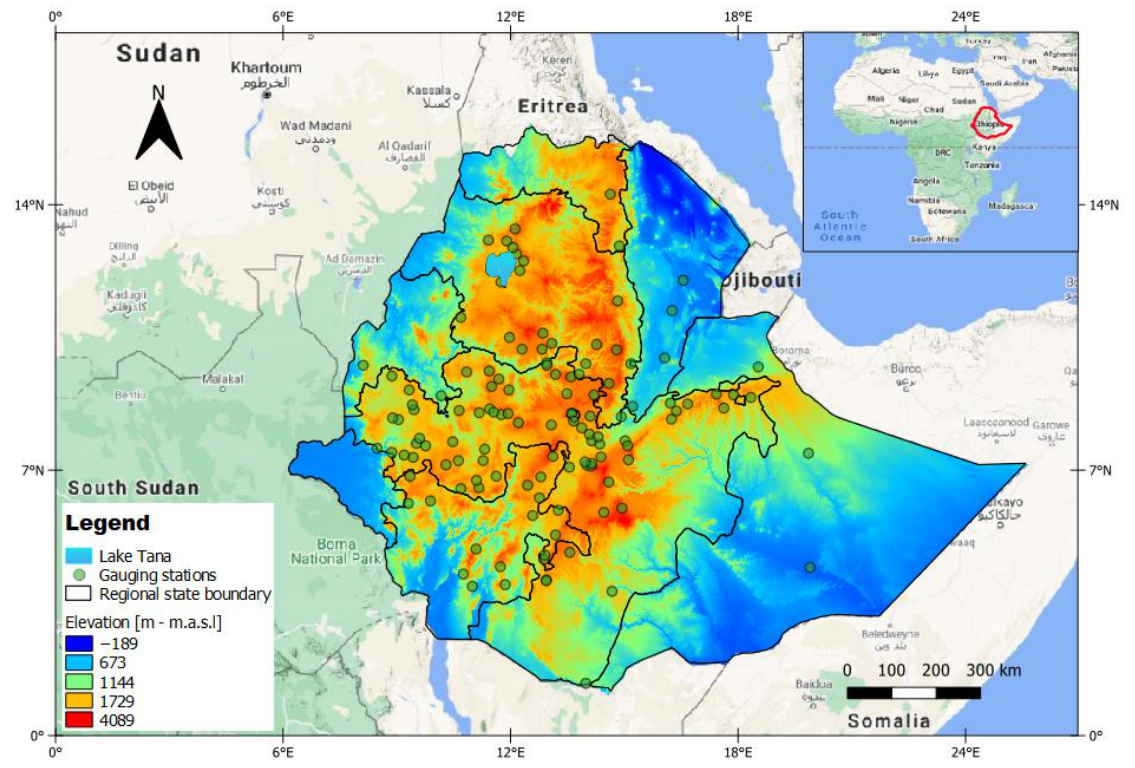
Figure 1. Elevation map for the study area together with the location of the 125 gauging stations used in this